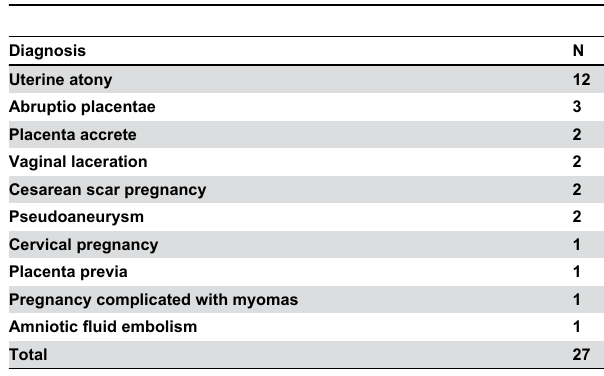
Table 1. Details of 27 pregnant women who underwent